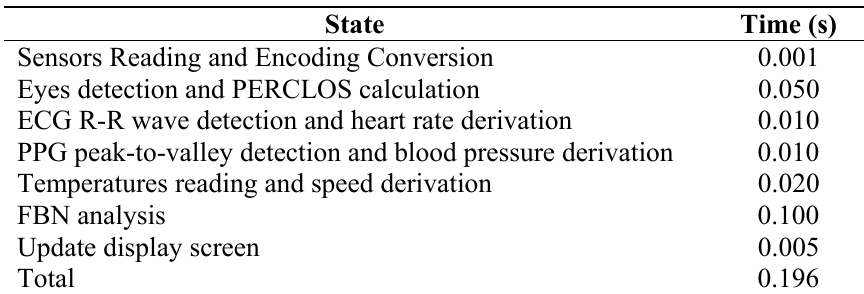
Table 4. Application processing